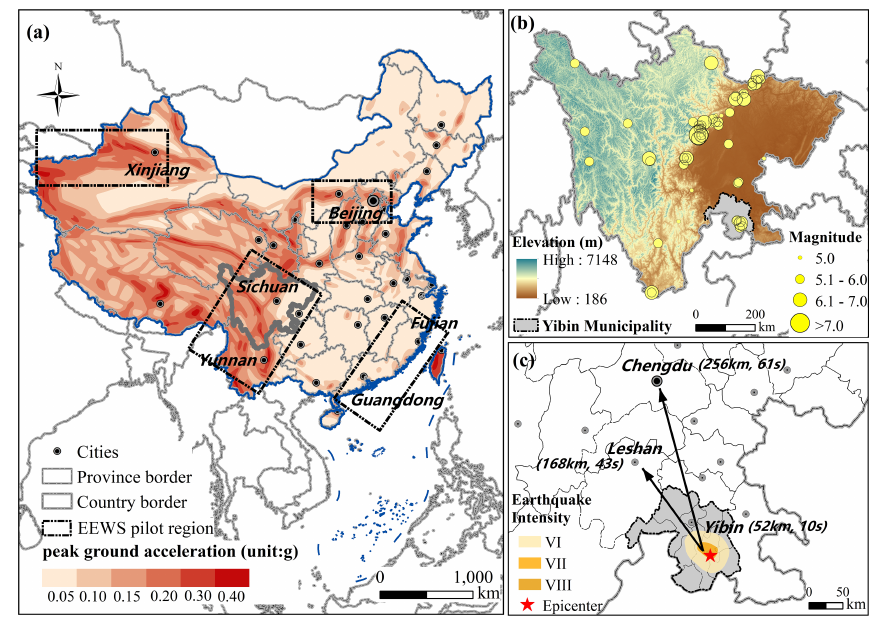
Figure 1. Seismic activity and EEWSs across China. (a) Distribution of earthquake intensity and EEWSs in various Chinese regions (modified from seismic peak ground acceleration zonation map of China; Standardization Administration of the People’s Republic of China, 2015), (b) historical earthquakes (January 1949–August 2020) in Sichuan Province, and (c) location of the Changning